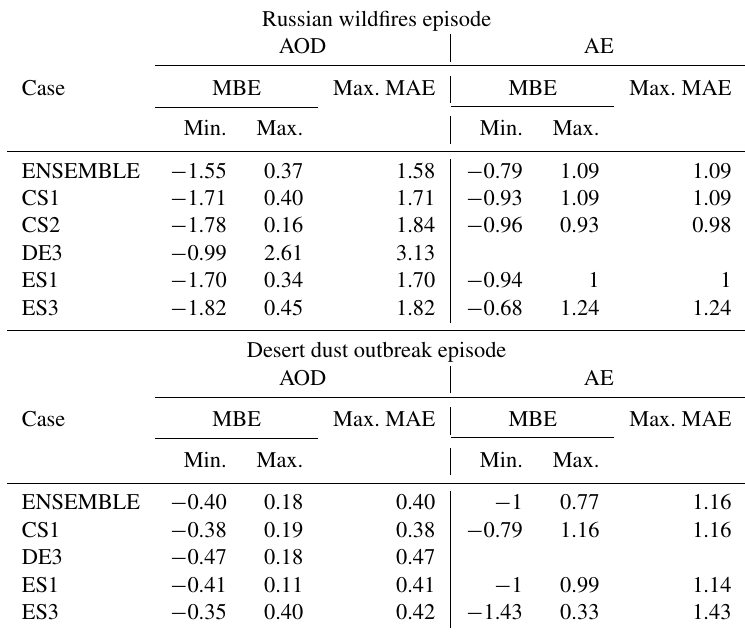
Russian wildfires episode AOD Case